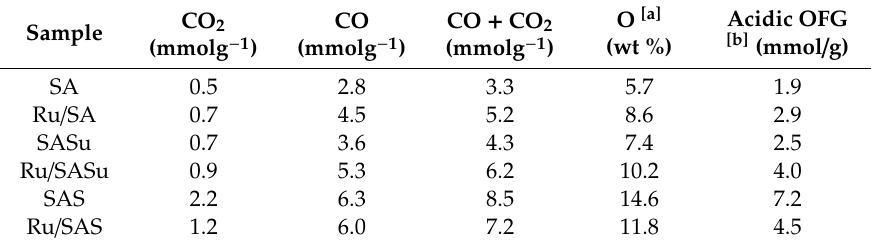
Table 2. Quantification of evolved CO 2 and CO in TPD experiments and the corresponding calculated O